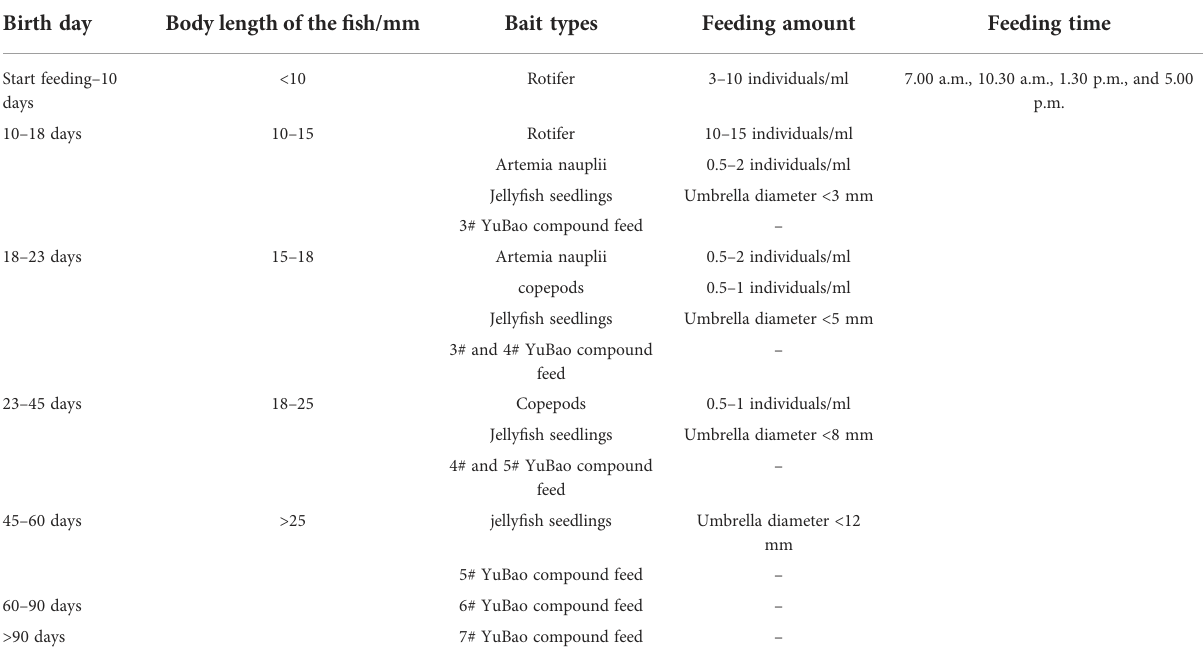
TABLE 1 Feeding sequence and feeding amount of P. argenteus